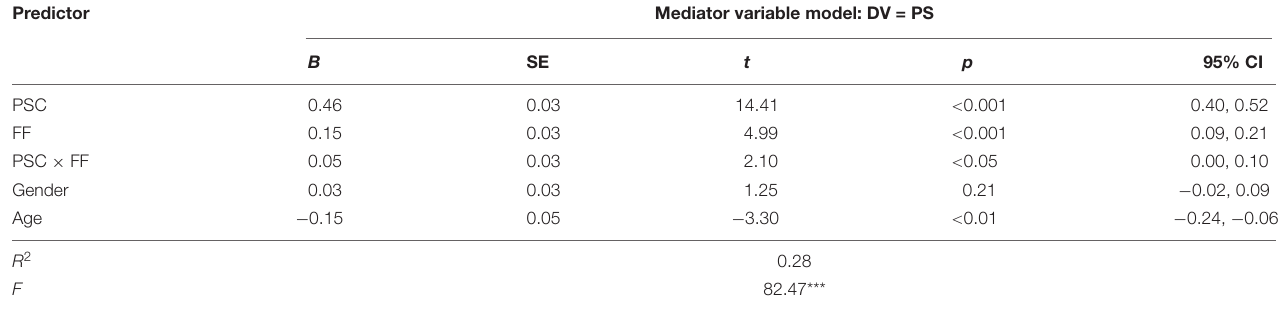
TABLE 3 | Moderated mediation analysis results with psychological suzhi as mediator.